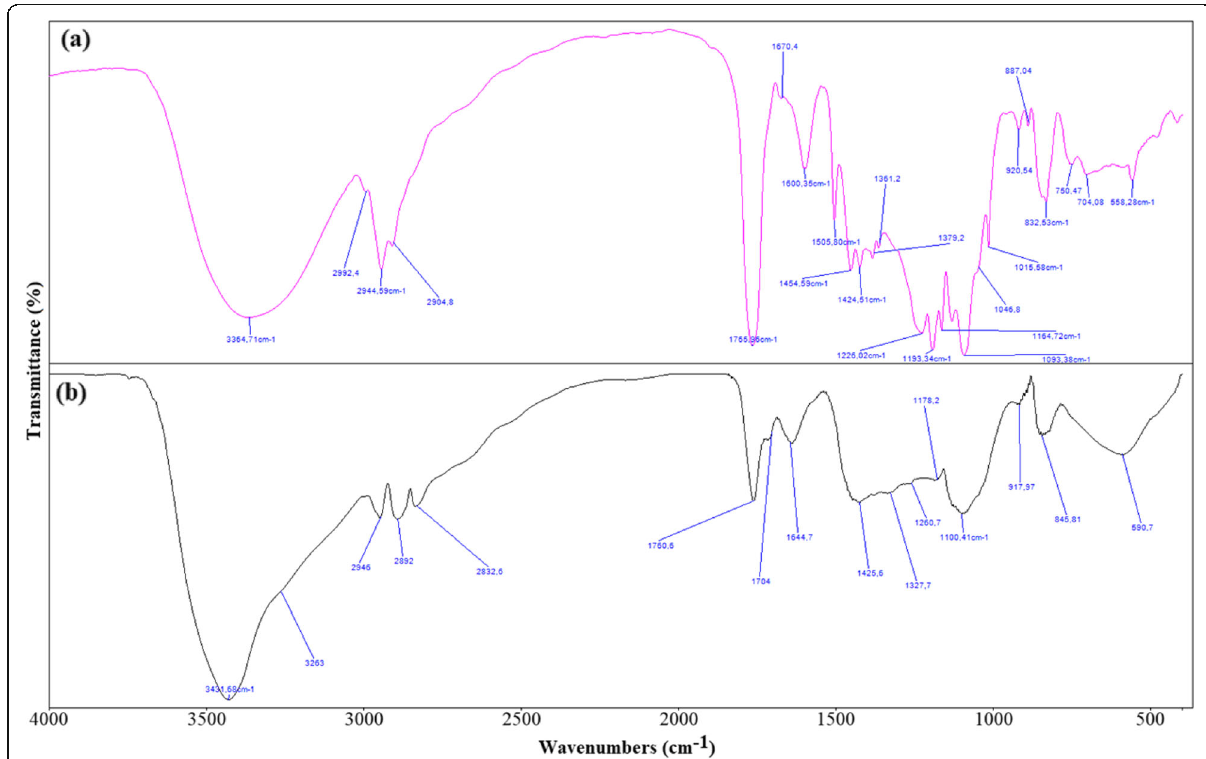
Fig. 3 FT-IR spectra of PLGA nanoparticles ( a ) and F-PLGA nanoparticles ( b